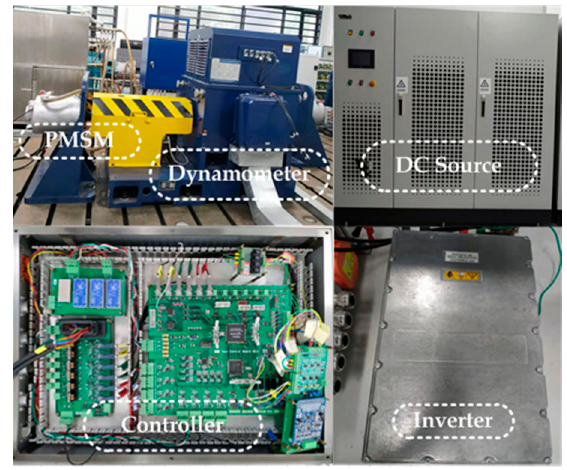
Figure 11. The experimental system.